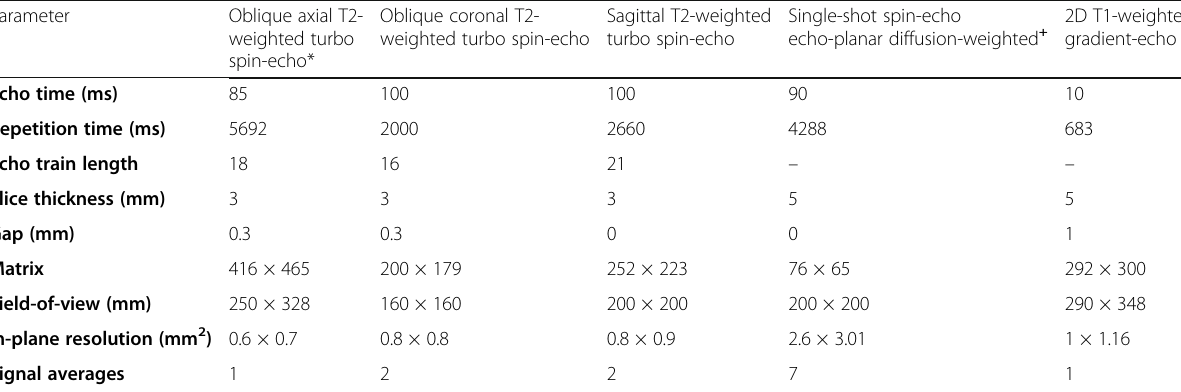
Table 1 MR acquisition parameters at a 1.5 T Ingenia Philips Healthcare®, Best, The Netherlands equipment